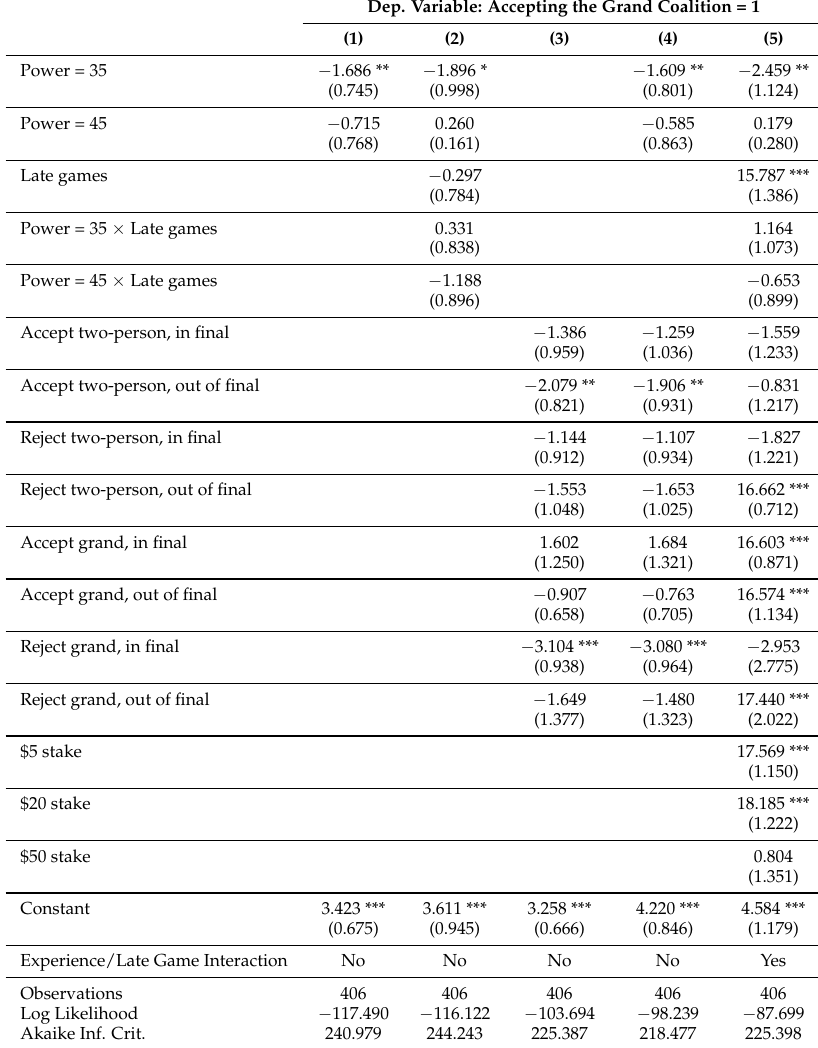
Table A5. Probability of accepting a grand coalition.